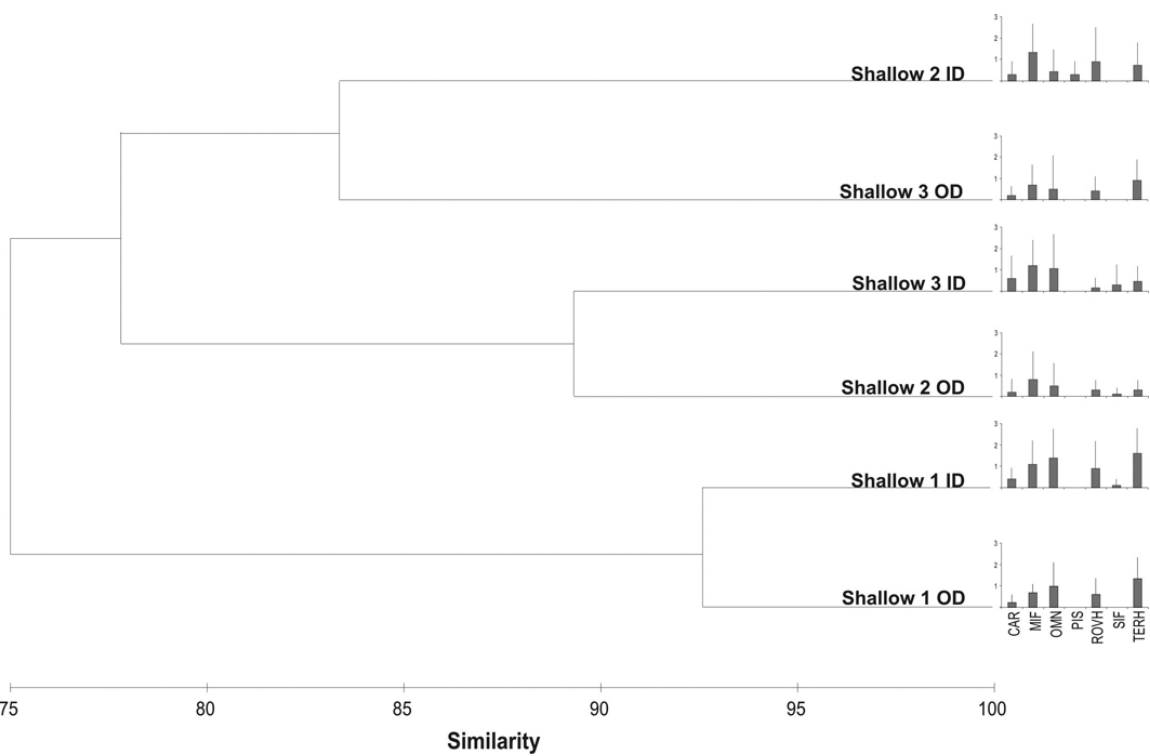
Fig. 8 – Similarity cluster analysis of trophic guilds among OD and ID patches on shallow zones of Maramutá reefs. CAR = carnivore; MIF = Microinvertebrate feeder; OMN = Omnivore; PIS = Piscivore; ROVH = Roving Herbivore; SIF = Sessile Invertebrate feeder; TERH = Territorial